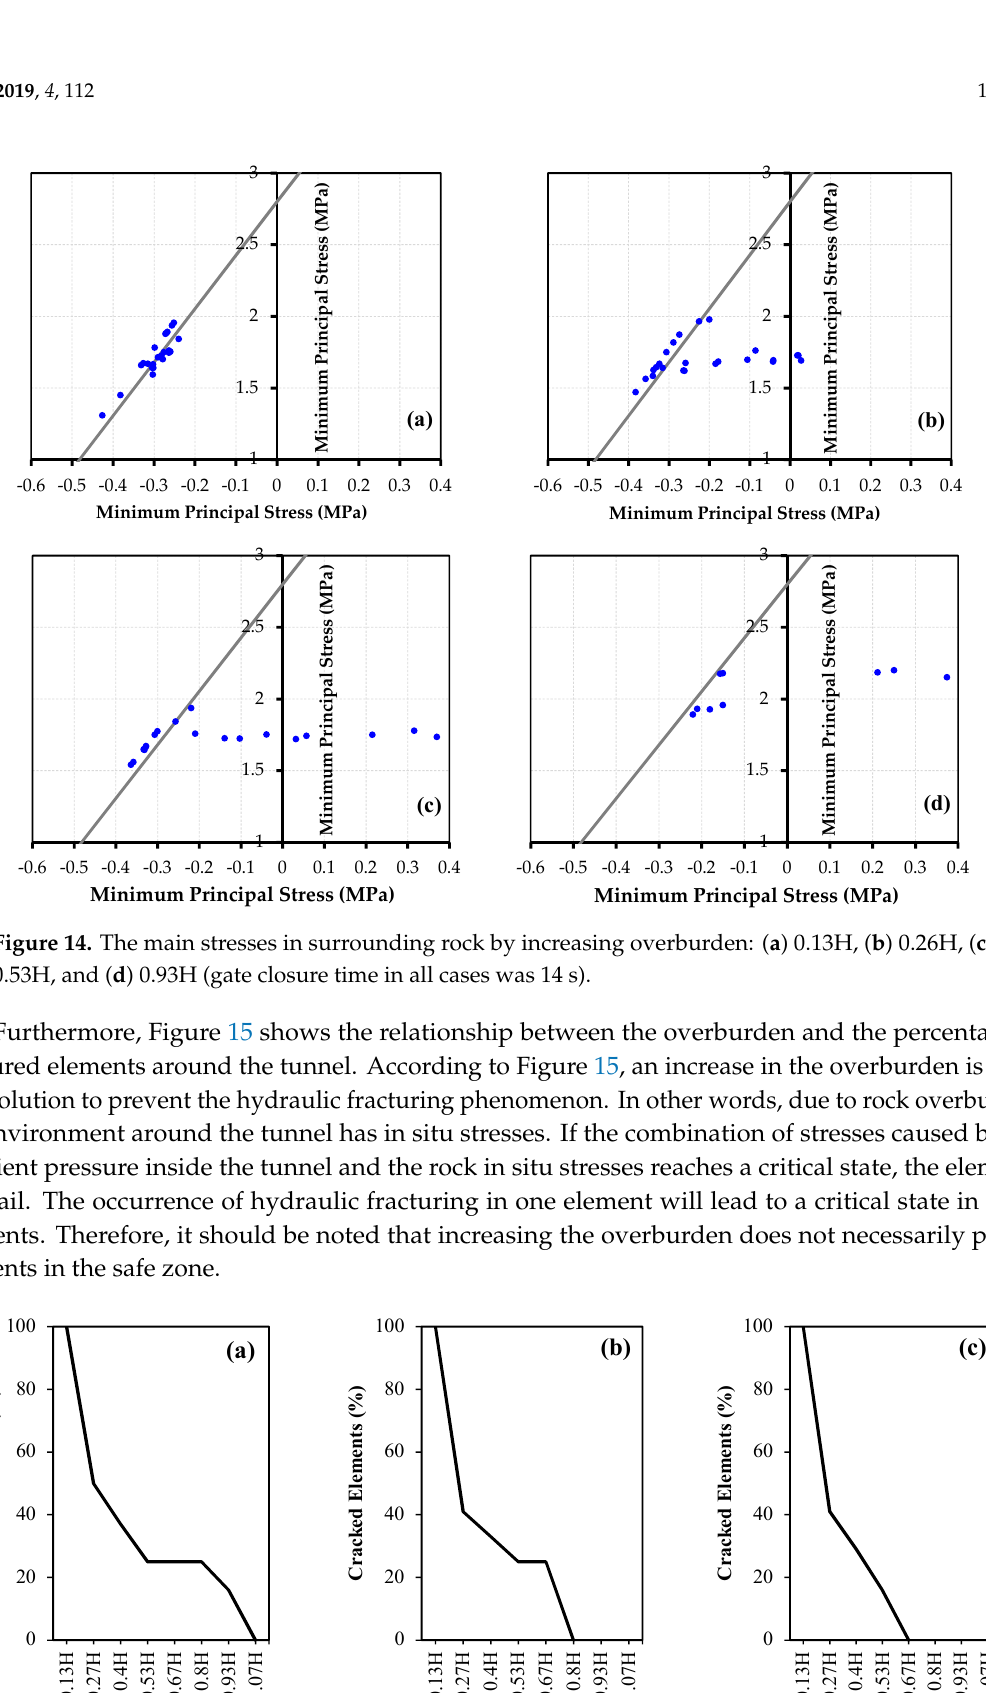
Figure 15. Percentage of cracked elements due to increased overburden height for gate closure times of ( a ) 14 s, ( b ) 18 s, and ( c ) 26 s.